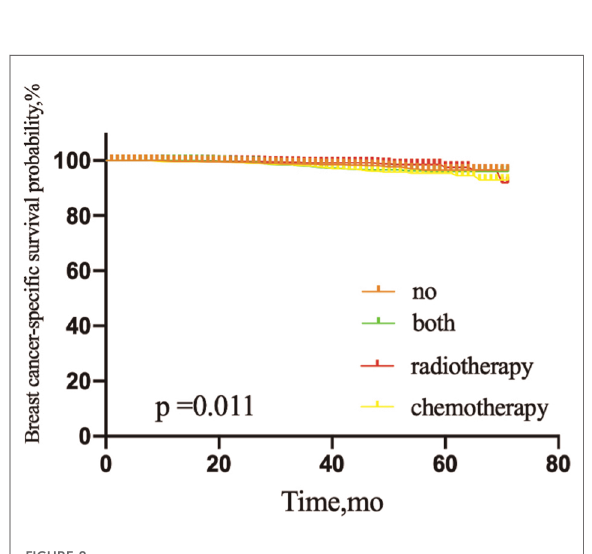
FIGURE 8 Breast-cancer-speci fi c survival of patients with 1 or 2 sentinel lymph node micrometastases treated with sentinel lymph node biopsy alone, according to adjuvant therapy. NO patients treated with no adjuvant therapies; BOTH patients treated with both adjuvant chemotherapy and radiotherapy; RADIOTHERAPY patients treated with adjuvant radiotherapy; CHEMOTHERAPY patients treated with adjuvant